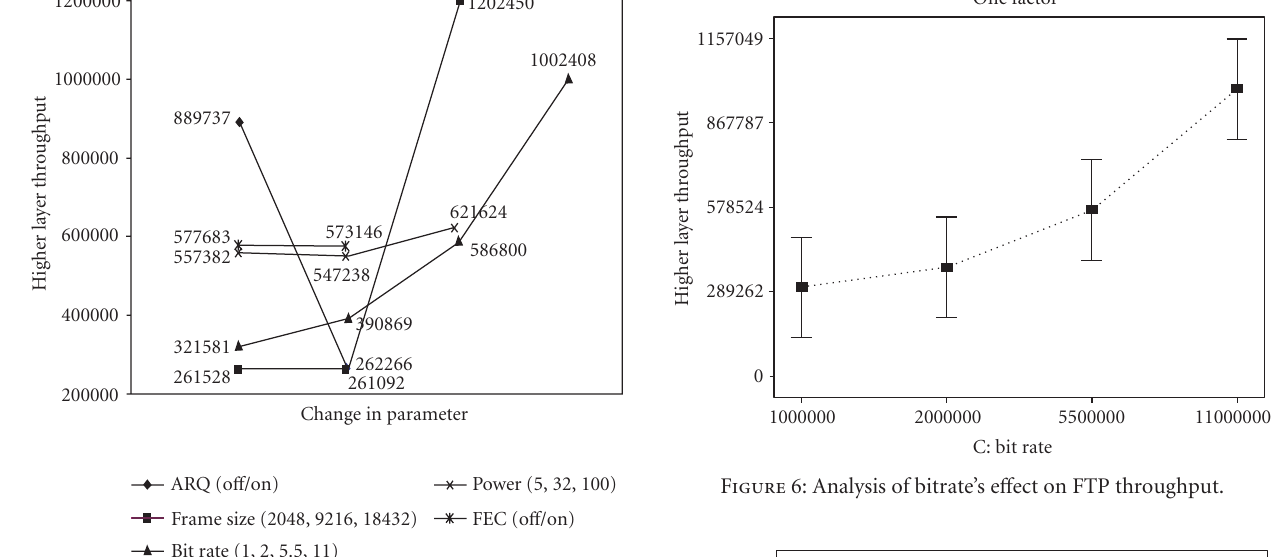
parameter settings. For FTP, the worst selection of param-